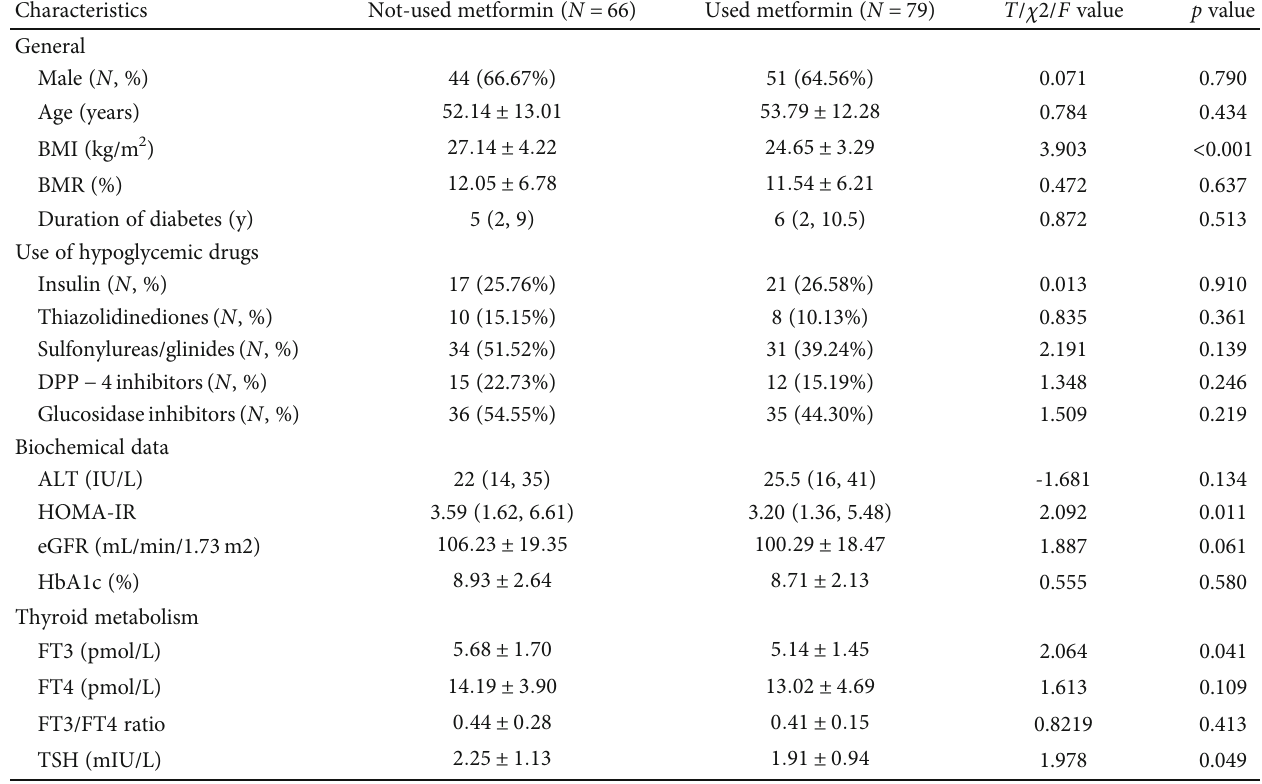
Table 4: Metabolism characterization of type 2 diabetes with NAFLD, grouped by metformin usage.